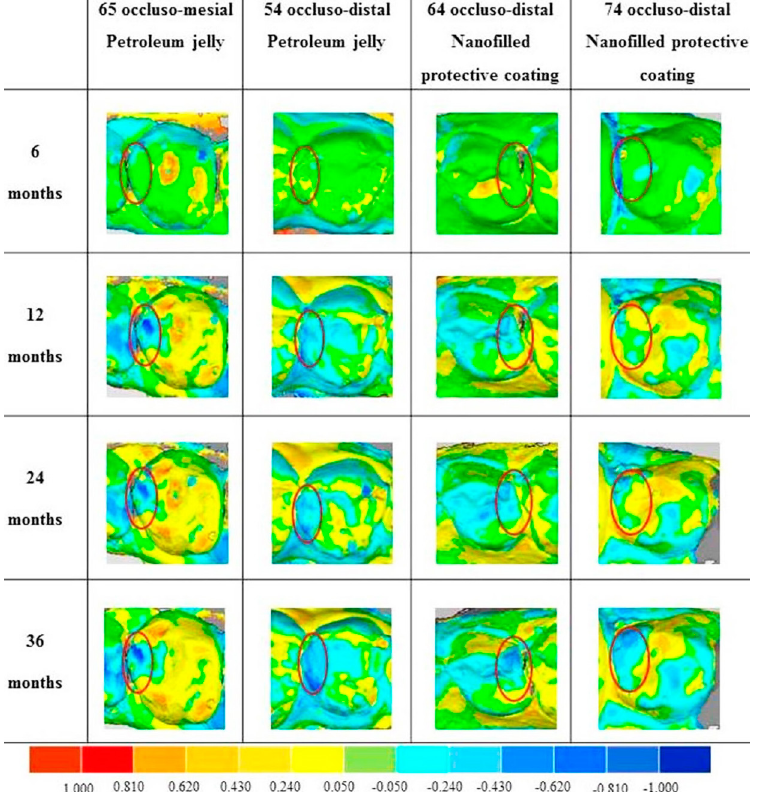
Figure 2- Representative images of the wear of restorations protected with petroleum jelly and a nanofilled self-adhesive light-cured protective coating measured after 6, 12, 24 and 36 months (from top to bottom), respectively. The red circle indicates the area where the restoration was placed. Color bar indicates surface wear (mm). From the right to the left, it is observed that shades of red and yellow indicate decreased wear of the surface, while increased wear of the surface is represented as darker shades of blue